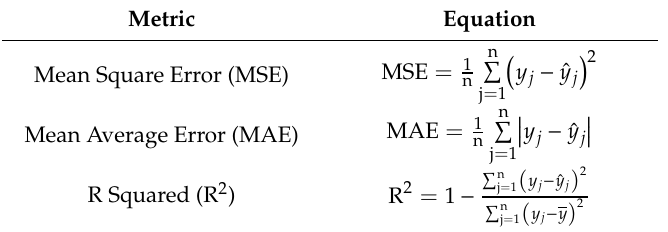
Table 5. Regression metrics.